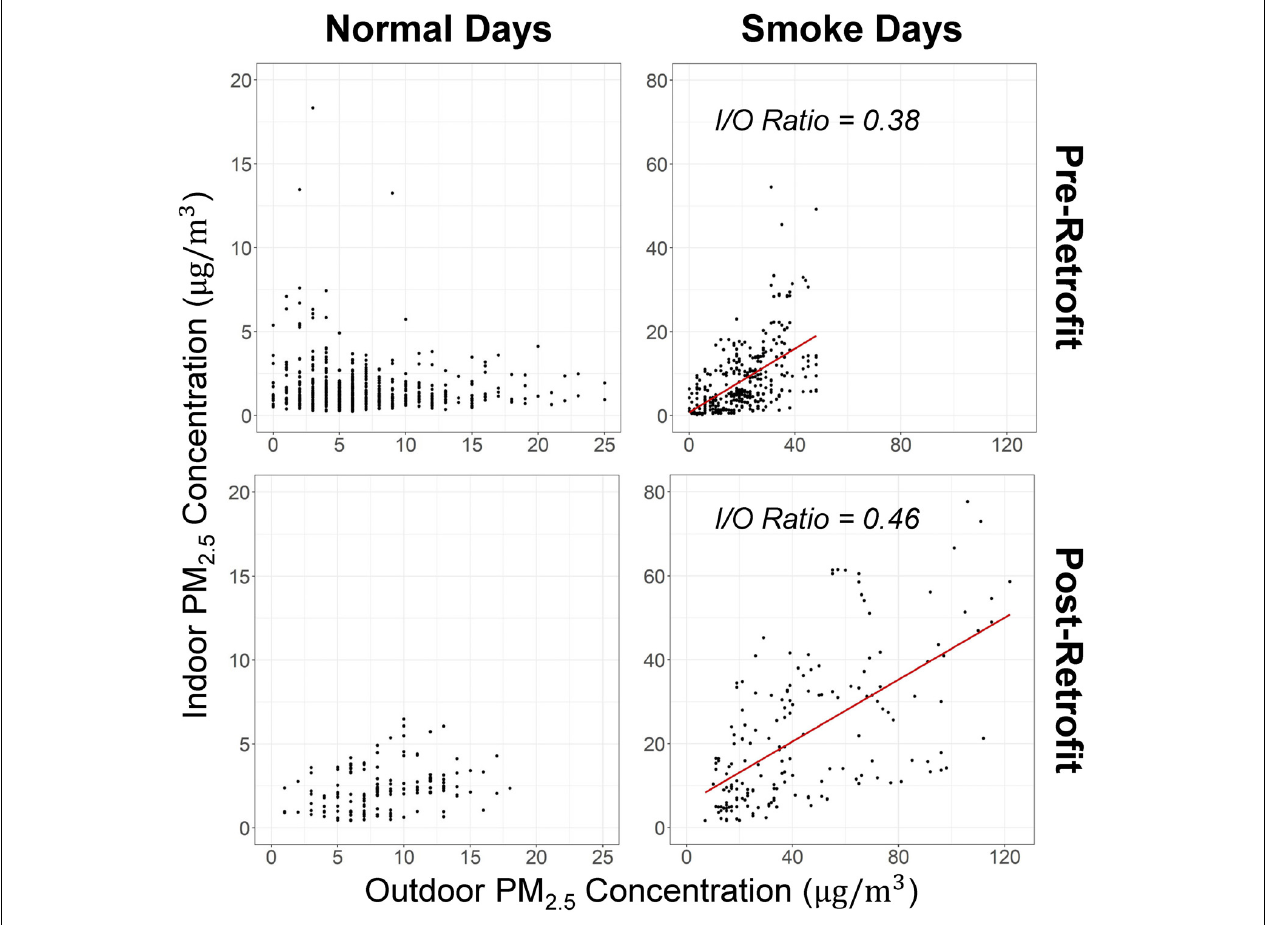
FIGURE 9 | Estimated I/O ratios for PM 2 . 5